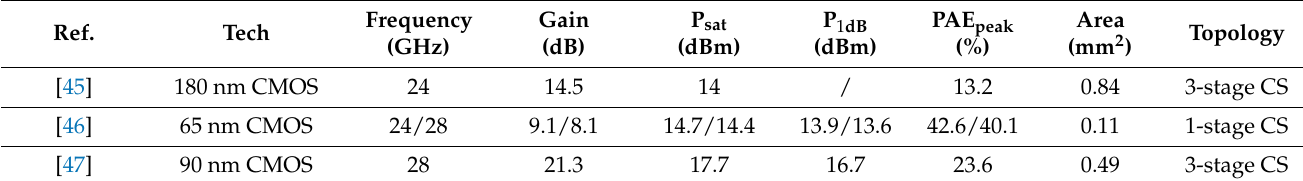
Table 1. Comparison of the measurement results with the CS PA.